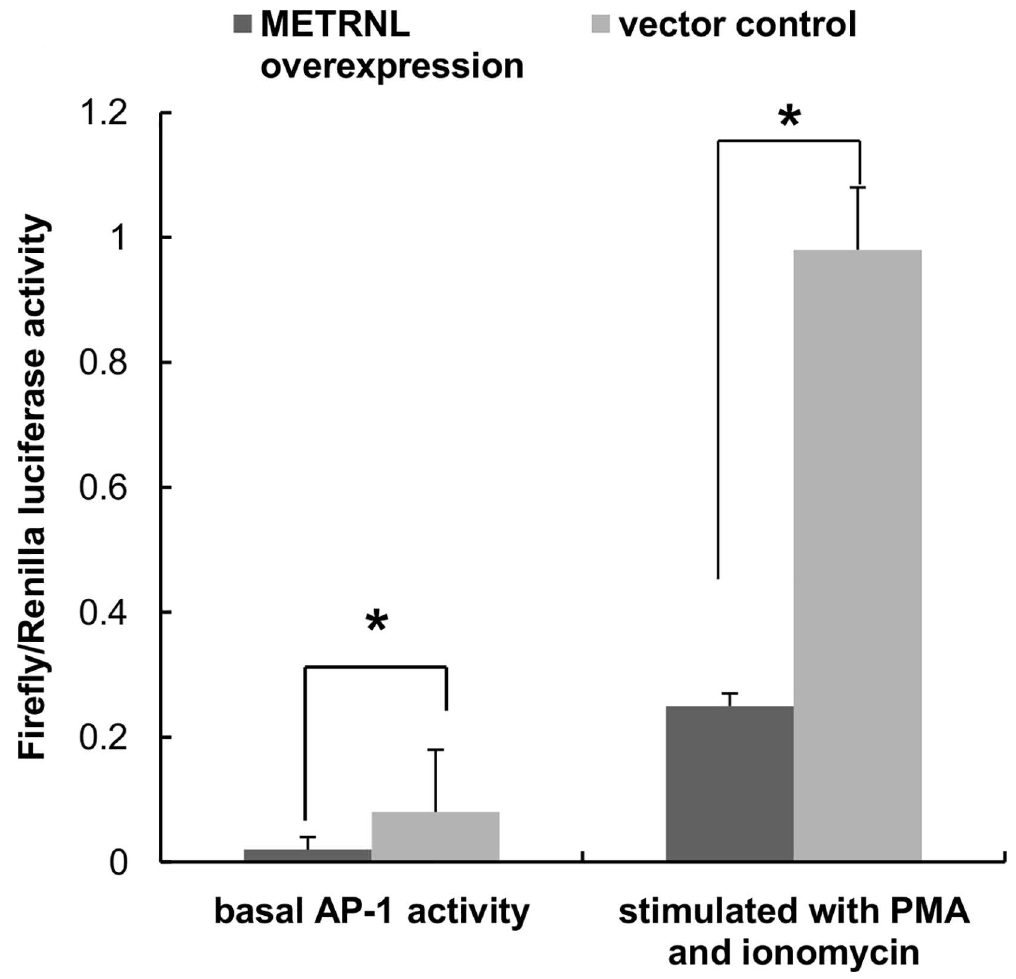
Fig 1. Overexpression of METRNL suppresses AP-1 transcription factor complex activity in 293T cells. In cells co-transfected with pCDNA3.1-METRNL, pAP-1, and pRL-TK, METRNL suppressed basal endogenous AP- 1 transcription factor complex activity. METRNL also inhibitedAP-1 transcription factor complex activation in cells treated with exogenous AP-1 activity stimulator (PMA and ionomycin). Data showingmeans from three independent experiments are presented after normalization for Renillaluciferaseactivity. * P <